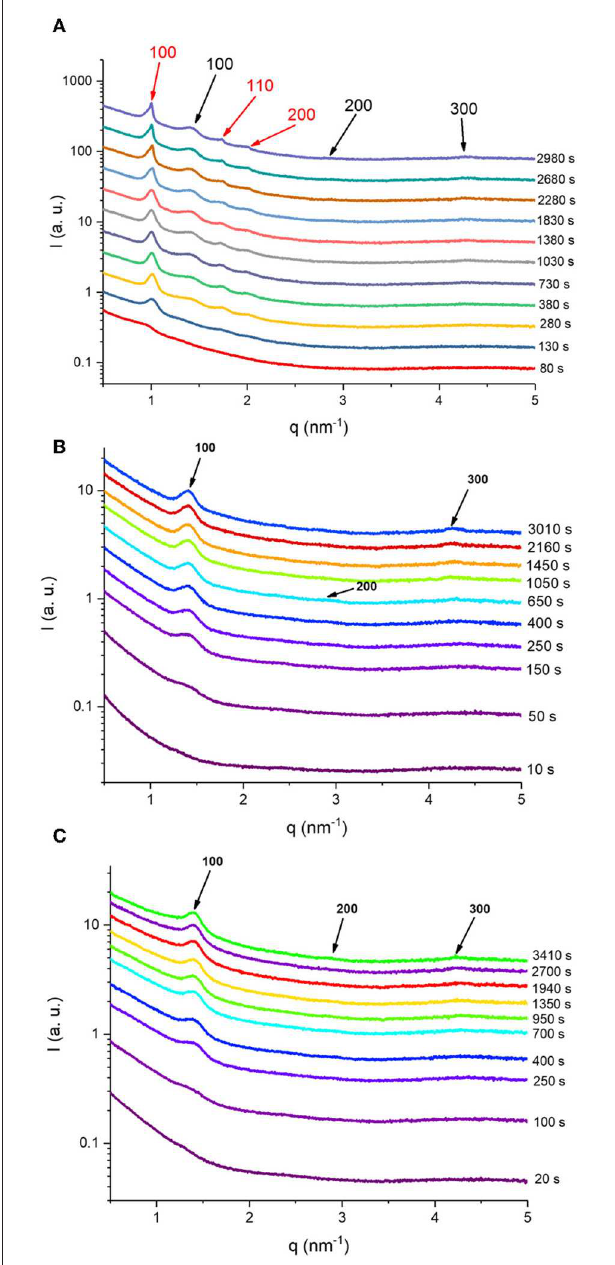
FIGURE 4 | Selected SAXS patterns are presented at different elapsed times for the three in situ digested KO emulsion (A) , and AO emulsions stabilized by using sodium caseinate (B) and citrem (C) . The Bragg peaks are represented with red and black colors for the corresponding Miller indices of the inverse hexagonal (H 2 ) and lamellar (L α ) phases, respectively. The intensities in (A–C) have been shifted by a constant arbitrary factor for better visibility.